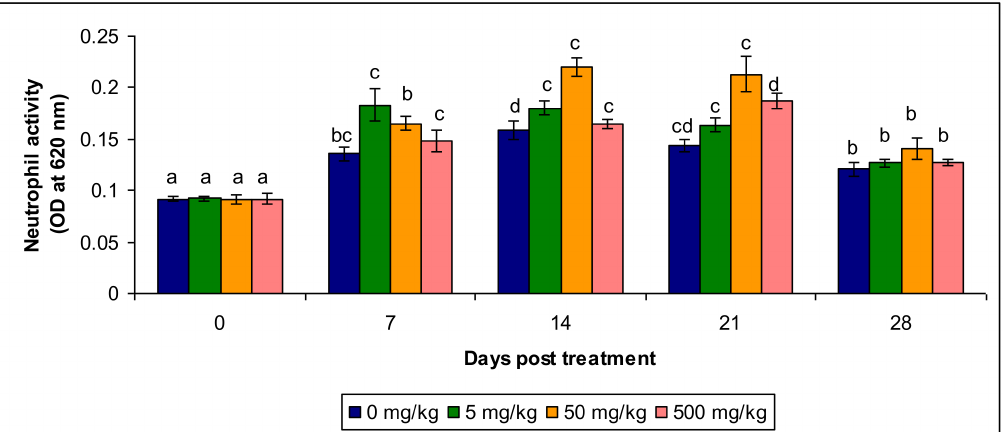
Figure 1. Neutrophil activity (OD at 620 nm) under different treatments administered with various levels of C. aerea extract in L. rohita during post-treatment days (values are mean ± SE). Mean values with different superscript within a column for a parameter is significantly different ( p < 0.05).